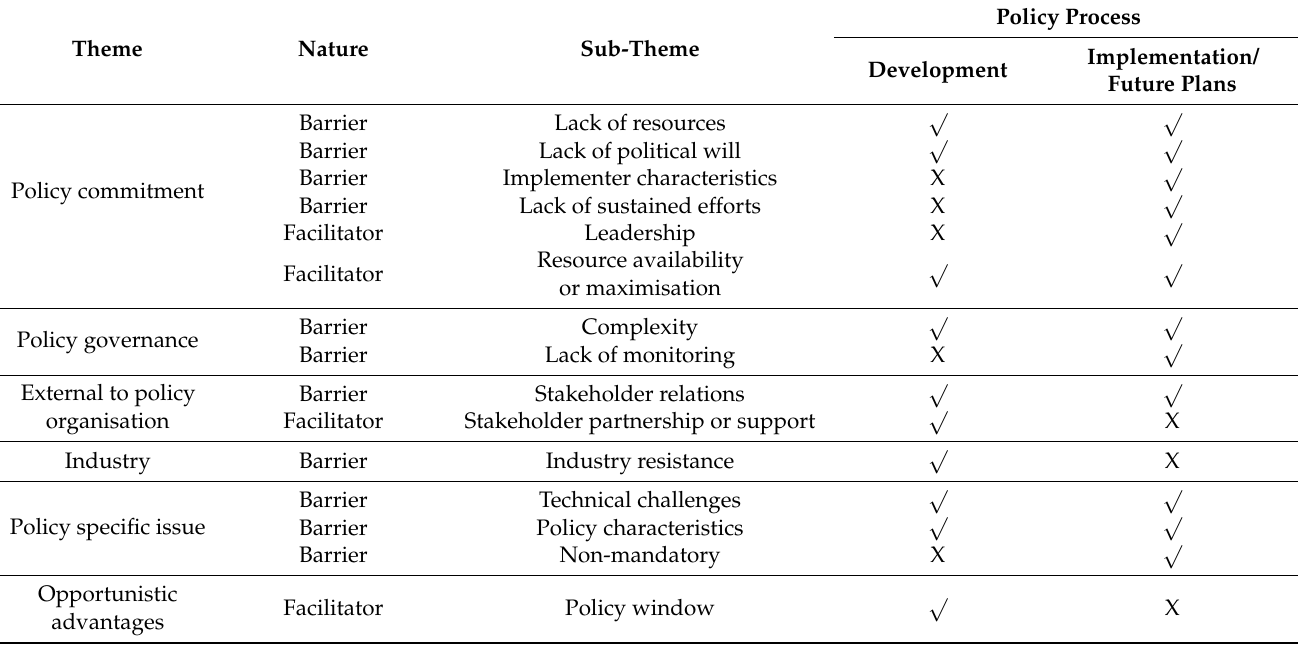
Table 1. Overview of thematic findings related to policy processes from